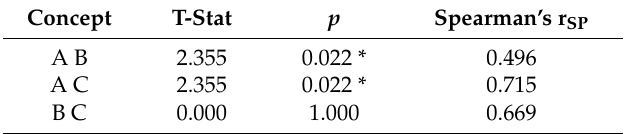
Table 8. Inferential statistics (Connover’s post-hoc) of controllability with Spearman’s r.